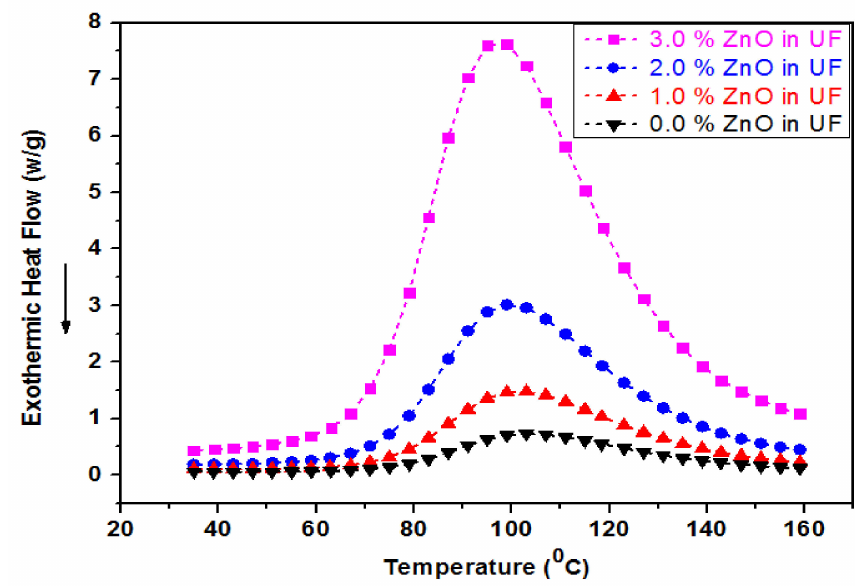
Figure 7. Differential Scan Calorimetry ( DSC ) of UF-ZnO Nanofillers.